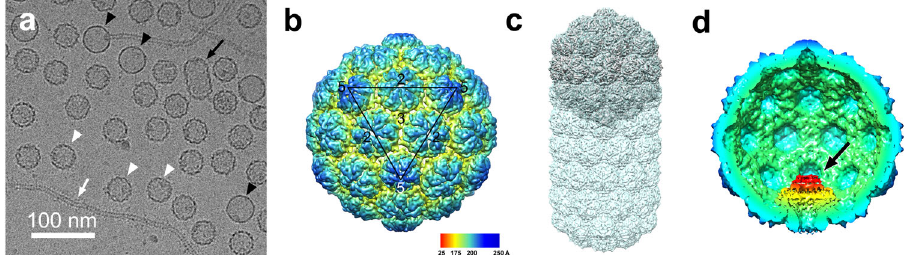
Fig. 2 Reconstruction of the SaPIbov5 procapsid. a Representative cryo-electron micrograph of capsids produced by induction of strain JP12419. Procapsids and expanded capsids are indicated by white and black arrowheads, respectively. A prolate capsid is indicated by the black arrow; the white arrow points to a ϕ 12 tail. Scale bar = 100 nm. b Isosurface representation of the icosahedral reconstruction of the SaPIbov5 (JP12419) procapsid, colored radially from the center according to the color bar. One icosahedral face is shown (black triangle), with two-, three-, and fi vefold symmetry axes indicated. c Superposition of the SaPIbov5 (JP12419) procapsid (silver) and ϕ 12 procapsid (semi-transparent blue surface) reconstructions. d Cutaway view of the C5 reconstruction of the SaPIbov5 (JP12419) procapsid showing the portal complex (black